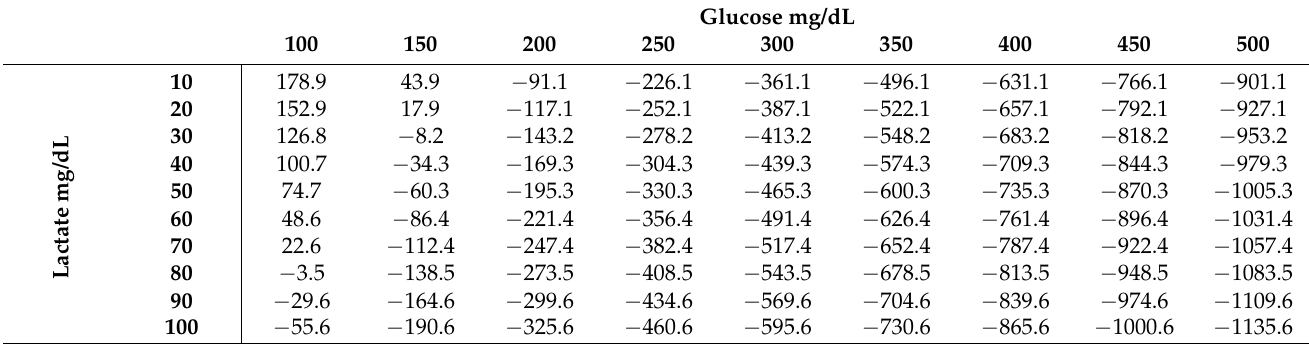
Table 4. Calculated net calorie balance per day (kcal/d) from CVVHD for different blood glucose (100–500 mg/dL) and lactate (10–100 mg/dL) concentrations with an exemplary citrate